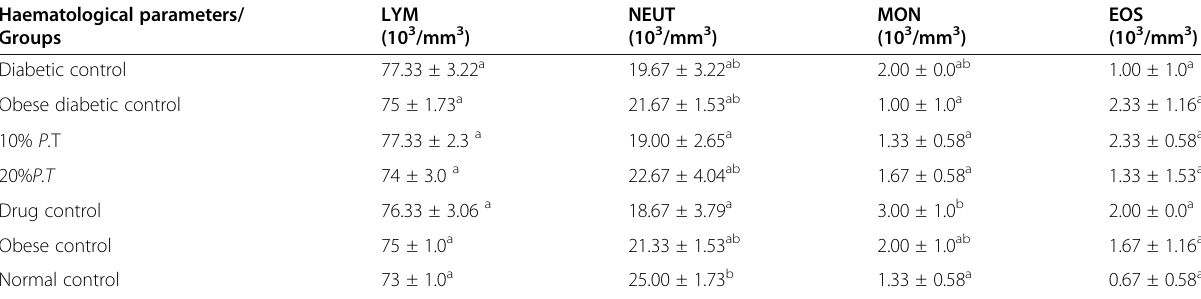
Table 8 Effect of Pleurotus tuber-regium on differential leucocytes of the diabetic rats Haematological parameters/ Groups